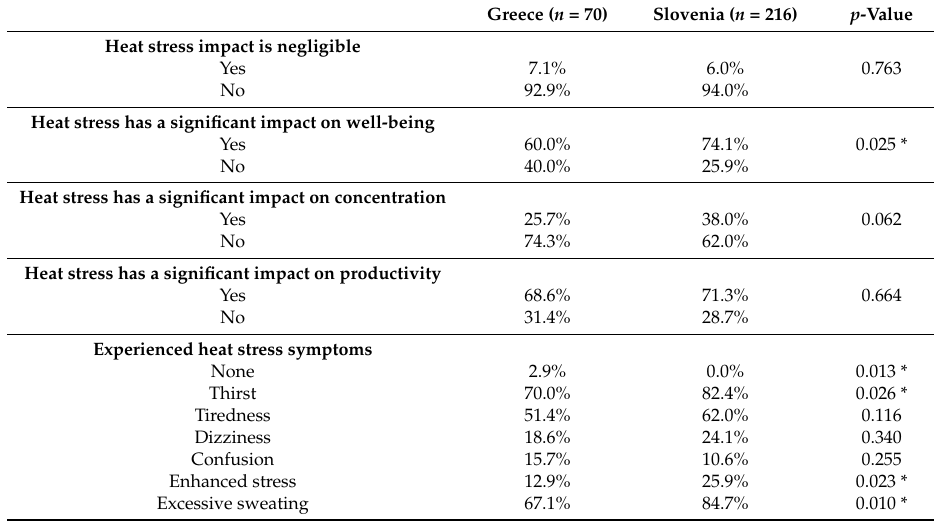
Table 2. A comparison of the questionnaire’s results in Greece and Slovenia—personal experiences of workers (* statistically significant difference between the